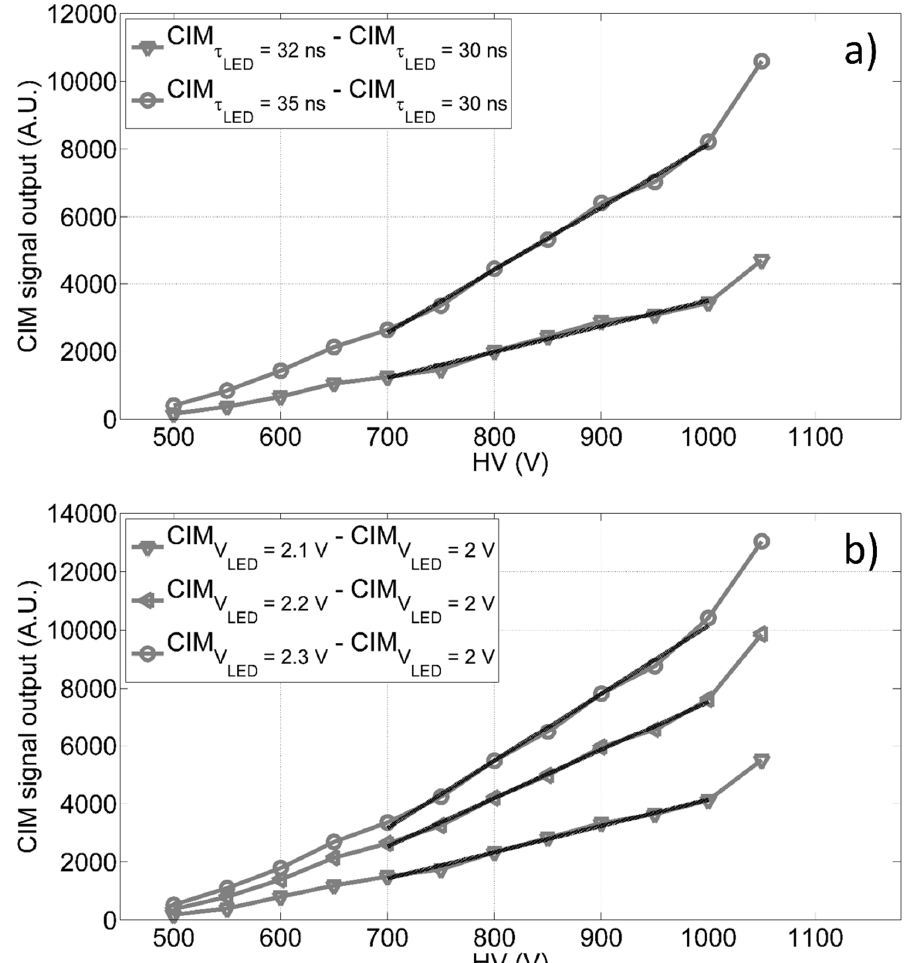
Figure 4. CIM di ff erential output as function of the anode to cathode voltage in diverse conditions: ( a ) di ff erence between the CIM output measured at 35 ns and 32 ns of pulse widths and the reference signal measured at 30 ns with constant pulse amplitude; ( b ) di ff erence between the CIM output at 2.1 V, 2.2 V and 2.3 V of LED pulse amplitudes and the reference signal observed at 2.0 V with constant pulse